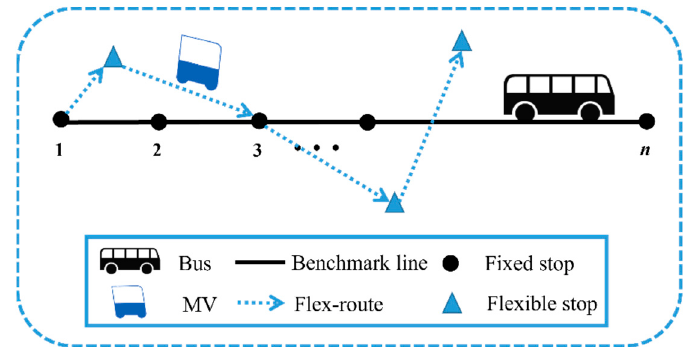
Figure 7. Flex-route scenario with linkage operation of EMVs and buses.